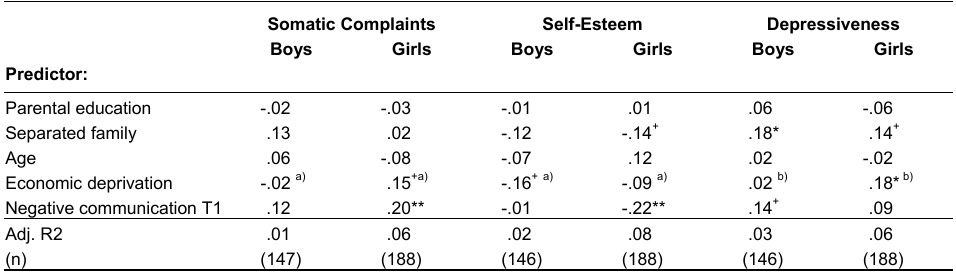
Table 6 : Negative maternal communication as mediator of long-term effects of economic deprivation Somatic Complaints